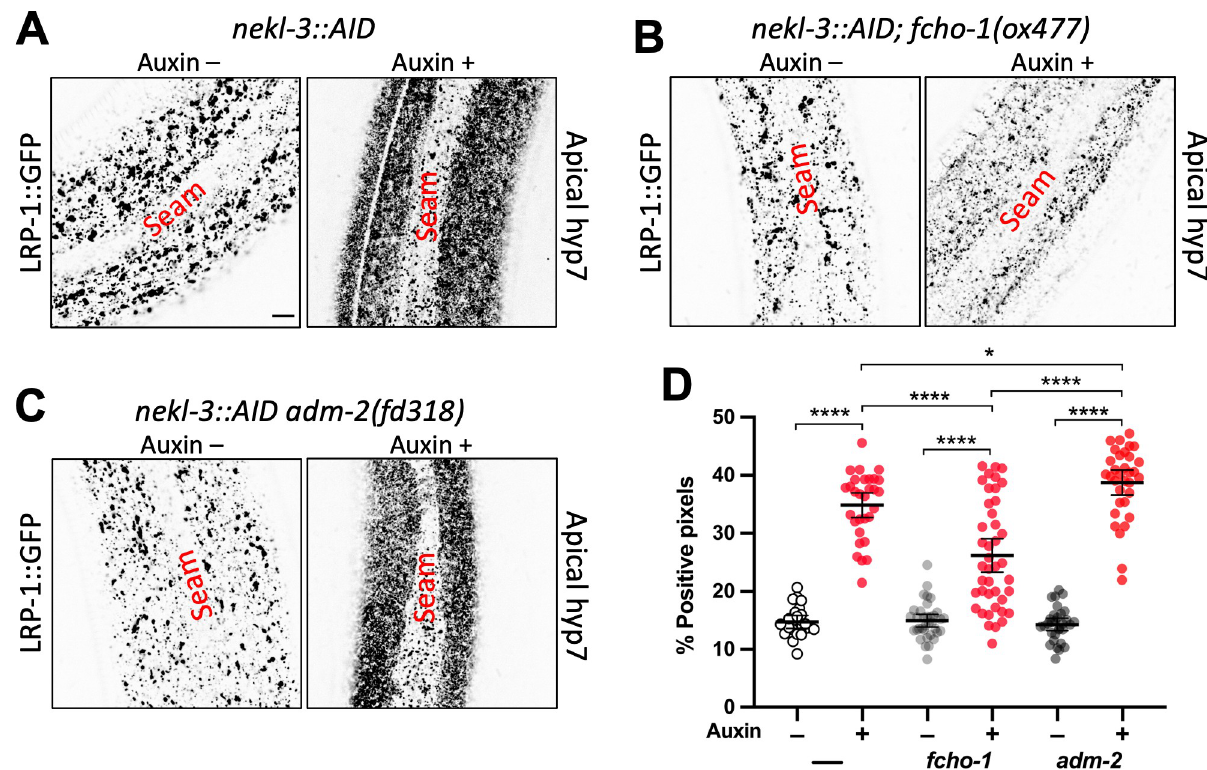
Fig 4. Loss of adm-2 function does not correct the nekl trafficking defects. (A–C) Representative confocal images of 2-day-old adult worms expressing LRP-1::GFP in the apical hyp7 region of the epidermis. LRP-1 expression in the nekl-3 :: AID (A), nekl-3 :: AID ; fcho-1(ox477) (B), and nekl-3 :: AID; adm-2(fd318) (C) mutant backgrounds in the absence (–) and presence (+) of auxin treatment. Bar in A = 5 μ m (for A–C). (D) Dot plot showing the percentage of GFP-positive pixels within the apical plane of the worm epidermis for individuals of the specified genotypes and auxin treatment groups. Group means along with 95% confidence intervals (error bars) are indicated. p-Values were obtained by comparing means using an unpaired t-test: ���� p � 0.0001, � p � 0.05. Raw data for this figure is provided in S1 File.